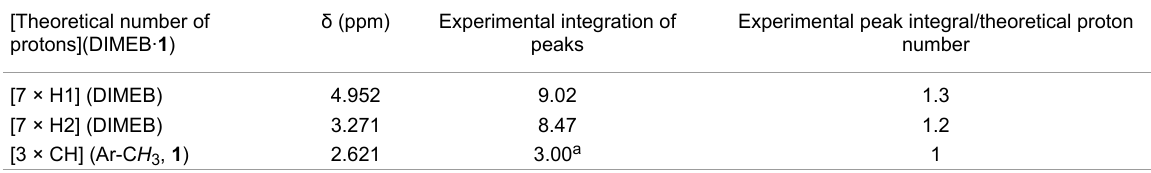
Table 1: Integrals of the NMR signals for the protons of solid complex DIMEB· 1 dissolved in CDCl 3 used to confirm the complex stoichiometry.